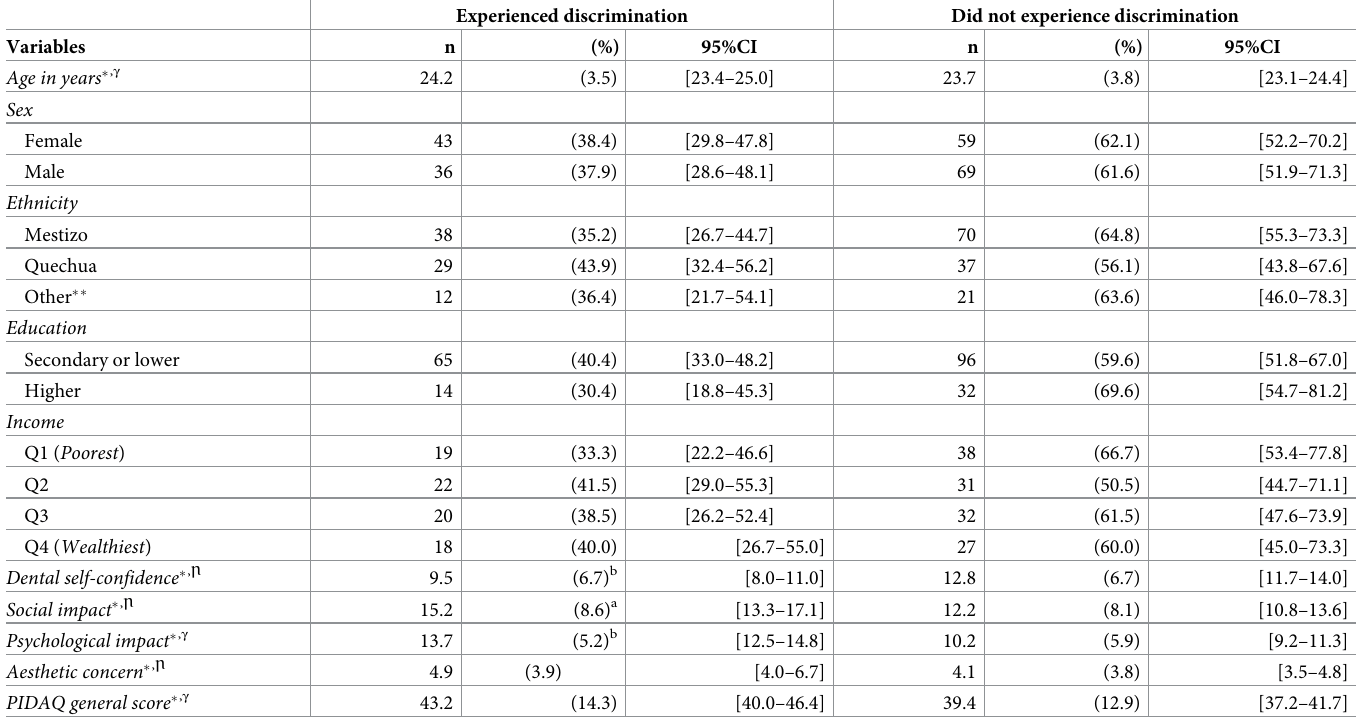
Table 2. Prevalence of experiencing discrimination and participant’s characteristics among 207 outpatients from a Peruvian public